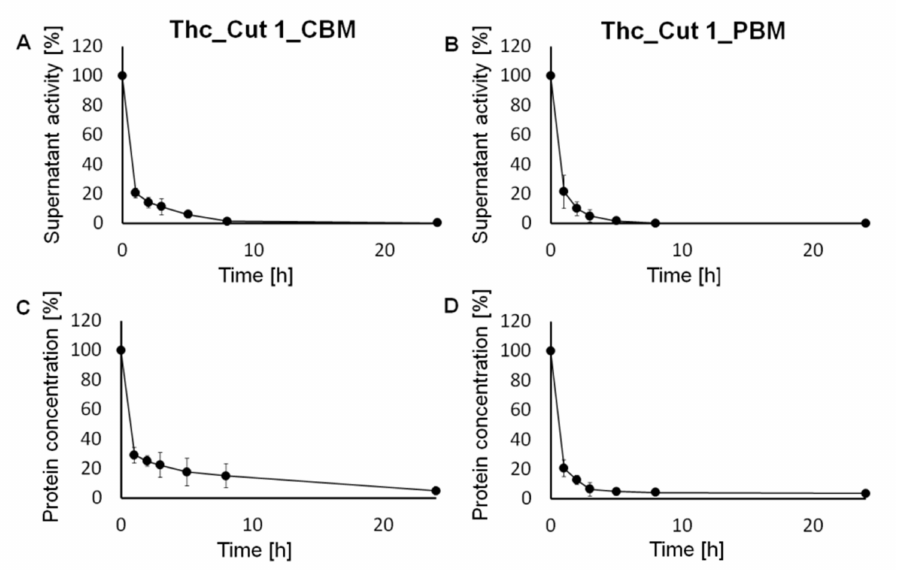
Figure 1. Thc_Cut1_CBM ( A ) and Thc_Cut1_PBM ( B ) immobilization profile on Resindion EC-EP/M epoxy-activated beads based on supernatant activity and Thc_Cut1_PBM ( C ) and Thc_Cut1_CBM ( D ) immobilization profile based on supernatant protein concentration. All experiments were performed in triplicates. Table 1. Immobilization yields and recovered activities of Thc_Cut1_CBM and Thc_Cut1_PBM immobilized on EC-EP epoxy-activated beads using 10 mg of protein per g of dry resin in 40 mL final